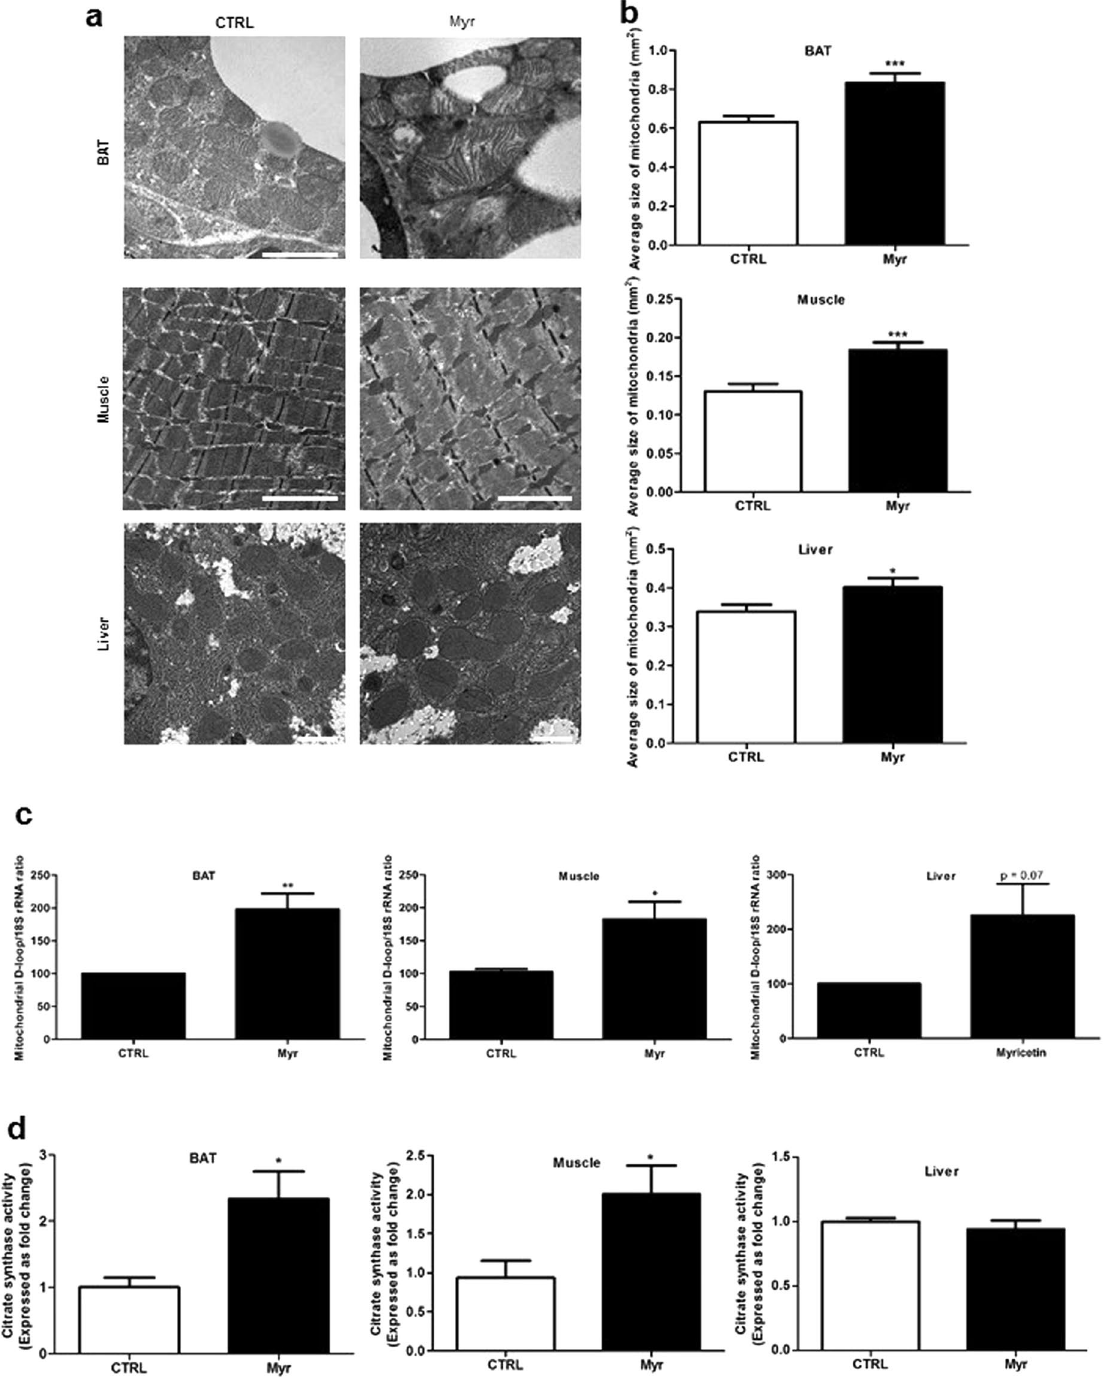
Figure 2. Myricetin increased mitochondrial activity in BAT and skeletal muscle. ( a ) Representative electron microscopy images of liver, BAT and skeletal muscle tissues from control and myricetin-treated mice. Scale bar: 2 μ m. ( b ) Quantification of mitochondria area of the indicated tissue. Mitochondria area was measured in liver (91–117 individual mitochondria), BAT (94–134), and skeletal muscle (117–173). N = 3–4 animals/ group. ( c ) D-loop regions of mitochondrial DNA (mtDNA) isolated from gastrocnemius muscle, BAT, and liver (n = 4 animals/group). ( d ) Activity of the citrate synthase, as measured with homogenates of BAT, liver, and gastrocnemius fibers isolated from myricetin-treated and nontreated mice (n = 3~6 animals/group). Unpaired Student’s t-tests, * = P < 0.05, ** = P < 0.005, *** = P < 0.0005. Values represent means ±